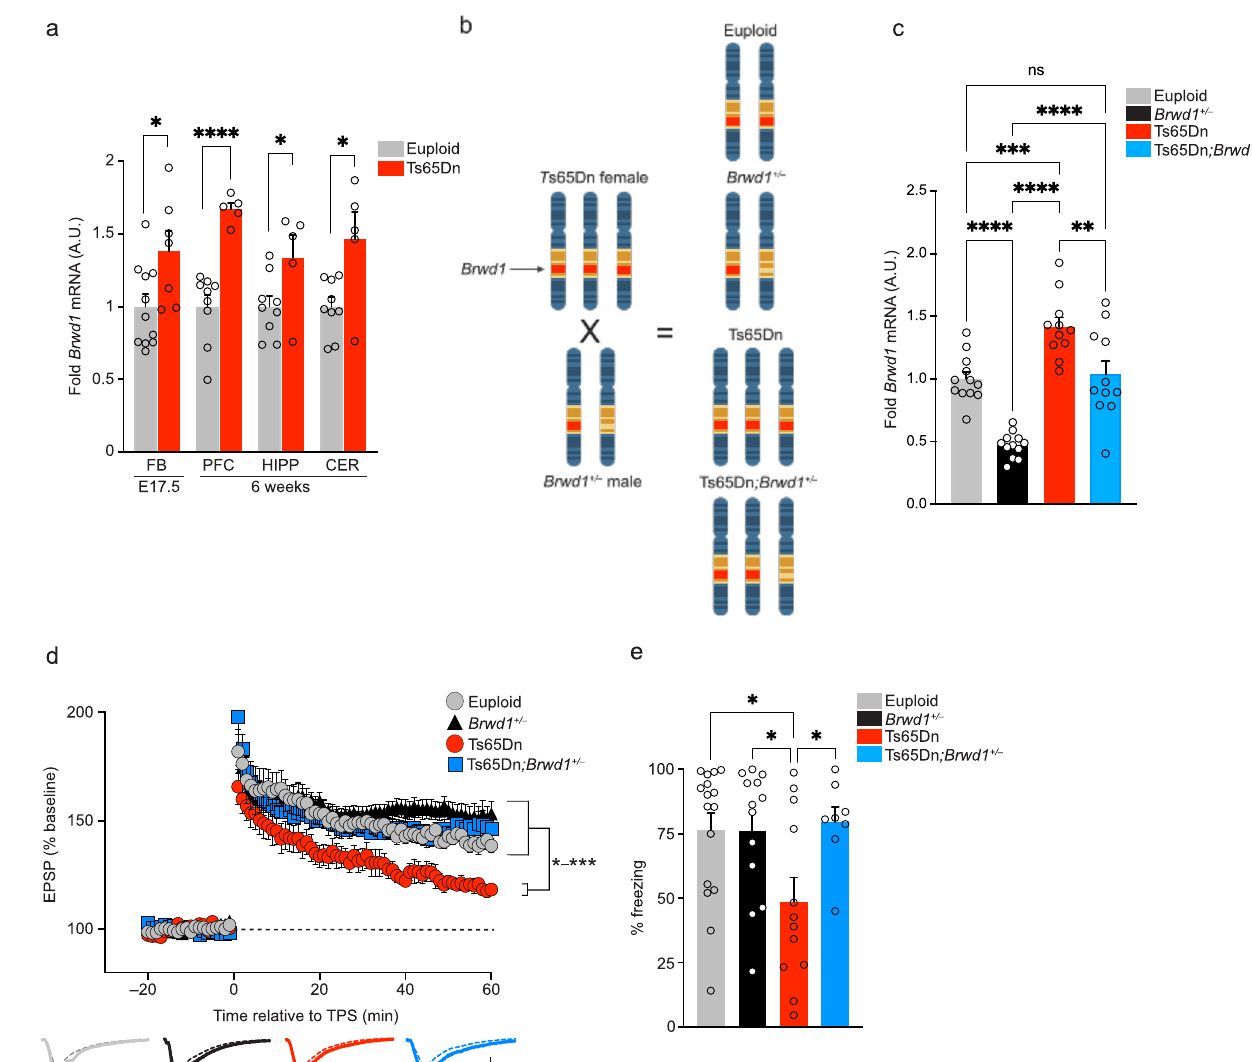
Fig. 1 | Brwd1 copy number restoration rescues synaptic and cognitive de fi cits in male trisomic animals.a qPCR expression data for Brwd1 in embryonic day (E) 17.5 forebrain (FB) and adult (6-week) PFC, hippocampus (HIPP) and cerebellum (CER)fromeuploid vs .Ts65Dnmalemice.A.U.=ArbitraryUnits,withexperimental (non-euploid) group averages normalized to respective euploid controls. b Schematic depicting the generation of mouse genotypes to be investigated. c qPCR expression data for Brwd1 in euploid vs. Brwd1 +/ – vs. Ts65Dn vs. Ts65Dn ;Brwd1 +/ – E17.5forebrain. d De fi ciency of hippocampalLTP in adultmale(6-